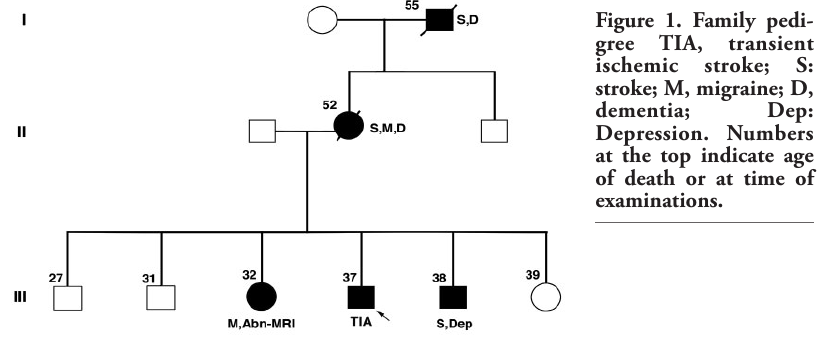
Figure 1. Family pedi- gree TIA, transient ischemic stroke;